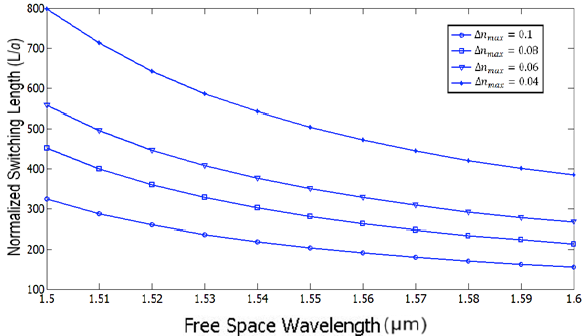
Figure 6: The relationship between the switching length of the PhC directional coupler and the wavelength for different values of maximum refractive index changes in the control